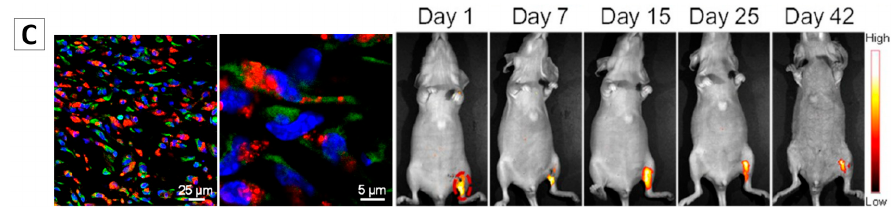
Figure 7. ( A ) HeLa cells traced by TPE-NSCS NPs at different passages and the fluorescence intensity of TPE in HeLa cells stained with TPE-PNIPAM at different passages [88]; ( B ) Long-term in vivo tracing for 21 days via labelling cells with AIE NPs [30]; ( C ) Tracking of ADSCs in vivo at single-cell resolution and representative time-dependent in vivo fluorescence images of the ischemic hind limb-bearing mouse that was intramuscularly injected with AIE dot-labeled ADSC-containing Matrigel [89]. Reprinted with permission from ref. [30,88,89], respectively. Copyright 2013 Nature, Copyright